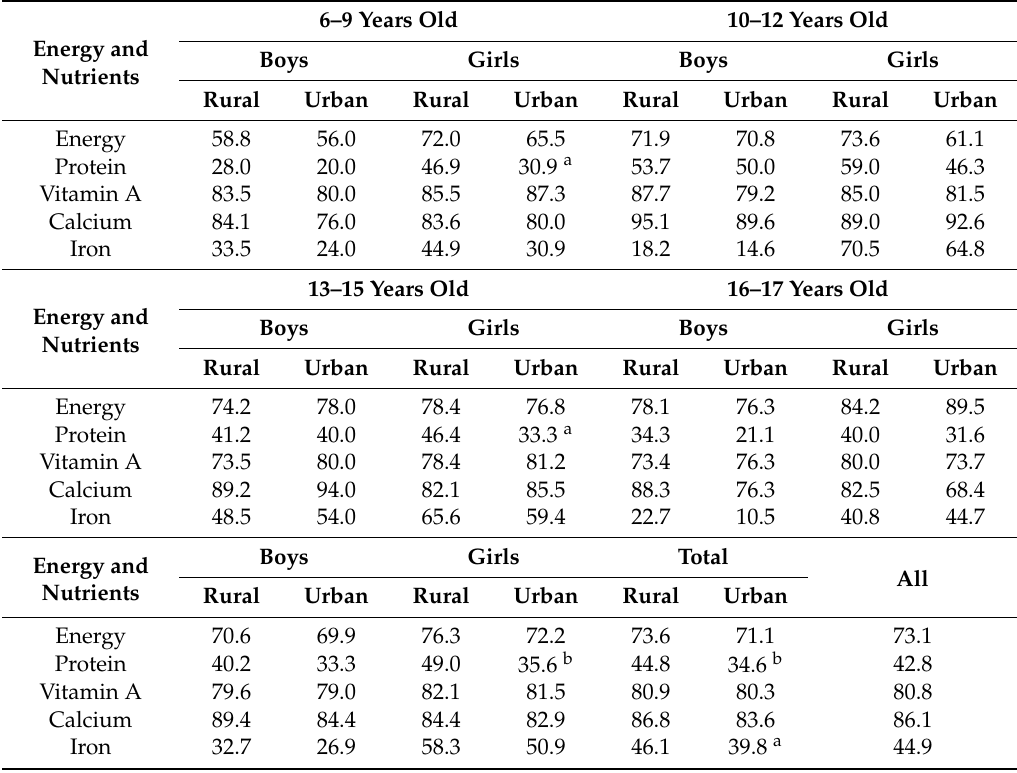
Table 4. Percentage † of children consuming selected energy, macronutrients, and micronutrients below the Cambodian Recommended Dietary Allowance (CAM-RDA) by age group, sex, and area of